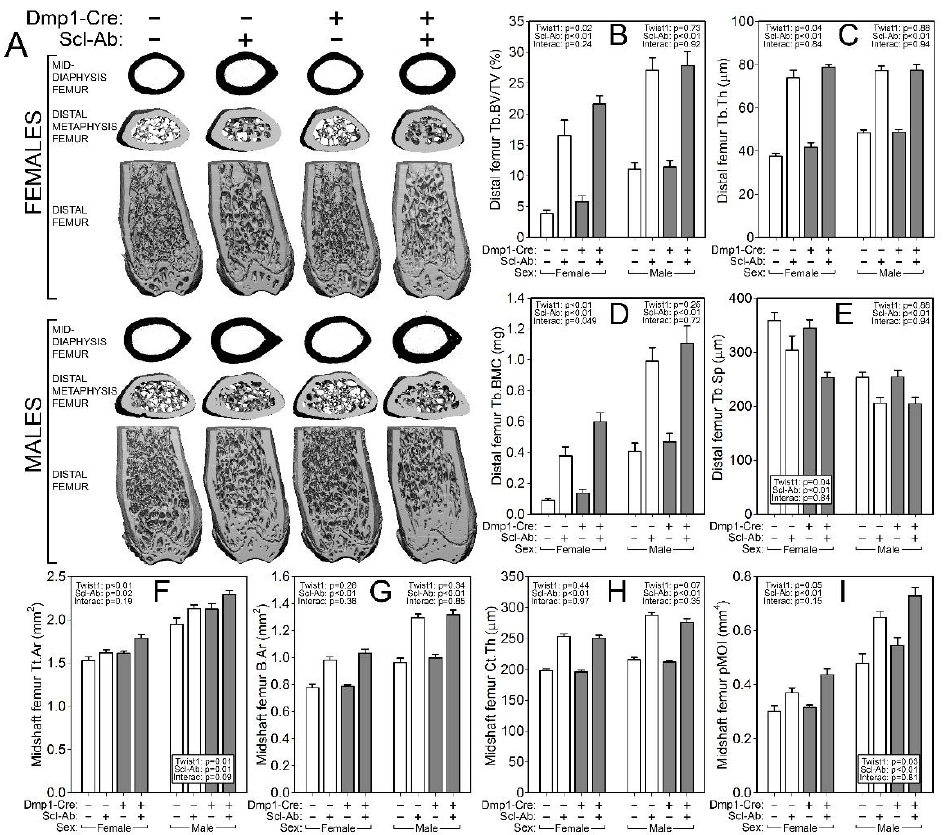
Figure 3. µCT-derived measurement of the distal femur metaphyseal cancellous bone and mid-femur cortical bone from Cre-negative (white bars) and 10kb Dmp1-Cre-positive (grey bars) Twist1 f/f mice at 16 wk of age, treated with or without sclerostin antibody (Scl-Ab) for 6 wk prior to sacrifice. ( A ) Representative 3D reconstructions of (top row) the midshaft femur, (middle row) the distal metaphysis (proximal view), and (bottom row) the caudal half of the distal femur (the ventral half was digitally removed). Female mice are in the top of the panel, males in the bottom. Quantitative differences in ( B ) femur trabecular bone volume fraction (BV/TV), ( C ) trabecular thickness (Tb.Th), ( D ) trabecular bone mineral content (Tb.BMC), and ( E ) trabecular separation (Tb.Sp) are shown for female (left side of each panel) and male (right side of each panel) mice. Quantitative differences in ( F ) femur cortical bone total area (Tt.Ar), ( G ) bone area (B.Ar), ( H ) cortical thickness (Ct.Th), and ( I ) polar moment of inertia (pMOI) are shown for female (left side of each panel) and male (right side of each panel) mice. Data were tested for significance using two-way ANOVA within sex, with Twist1 status and antibody as the main e ff ects (plus interaction), which are reported in the corner or base of each sex grouping; n = 8–11 /